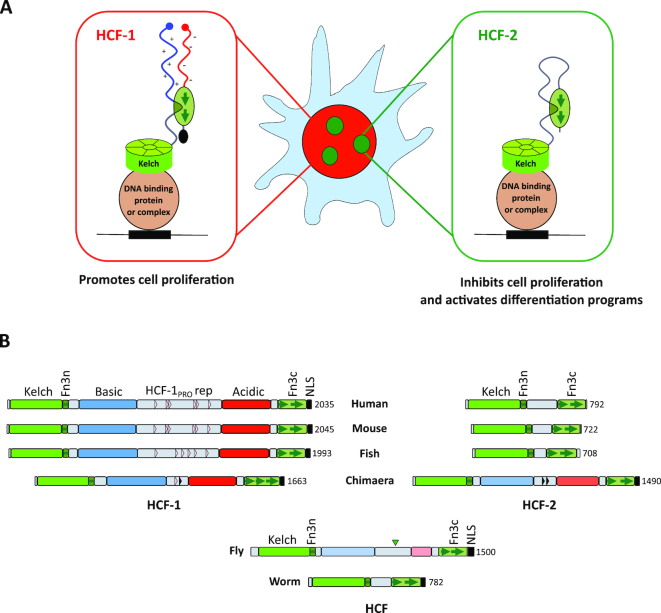
(A) Illustration of the different properties of human HCF-1 and HCF-2 proteins (see text for details). (B) Structural representation of HCF protein structures in worm, fly, chimera, fish, mouse and human. For the domain descriptions see text and Figure 1A legend. Inverted arrow head represents a Taspase 1 cleavage site in fly HCF; black triangles in chimera HCF-1 (one) and HCF-2 (two) indicate degenerate HCF-1PRO repeats. The intensity of the blue and red colors labeling the Basic and Acidic regions indicates relative basic and acidic residue abundance: human, mouse, fish HCF-1 > chimera HCF-1 and HCF-2 > Drosophila HCF.